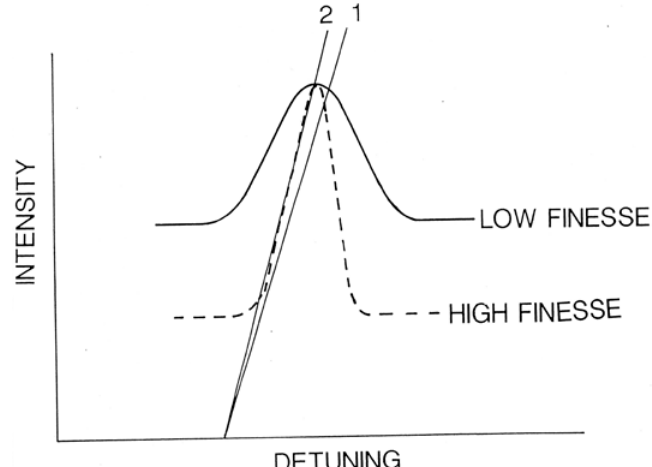
Fig.1: The intersection of the input power (straight line) with a high and low finesse curves